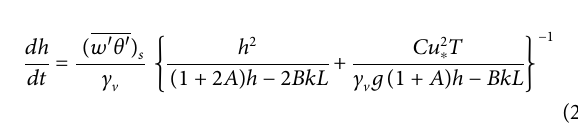
Frontiers in Remote